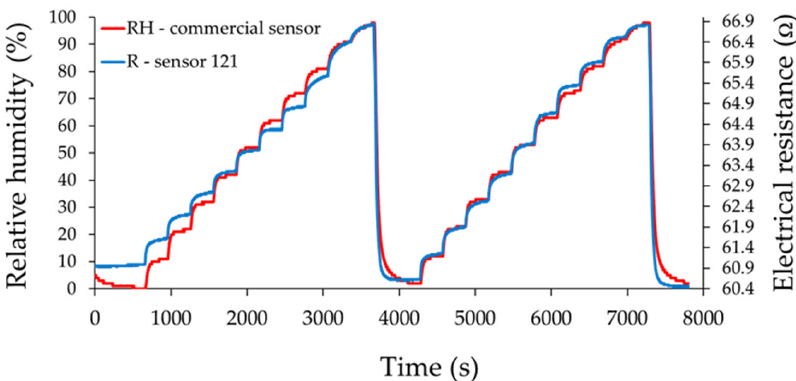
Figure 11. The response of the sensor 121 (“R curve”—blue) as a function of time for two measurement cycles, when relative humidity was increased in ten steps from 0% RH to 100% RH; “RH curve—red” shows the similar characteristic measured for a commercial, industrial sensor.